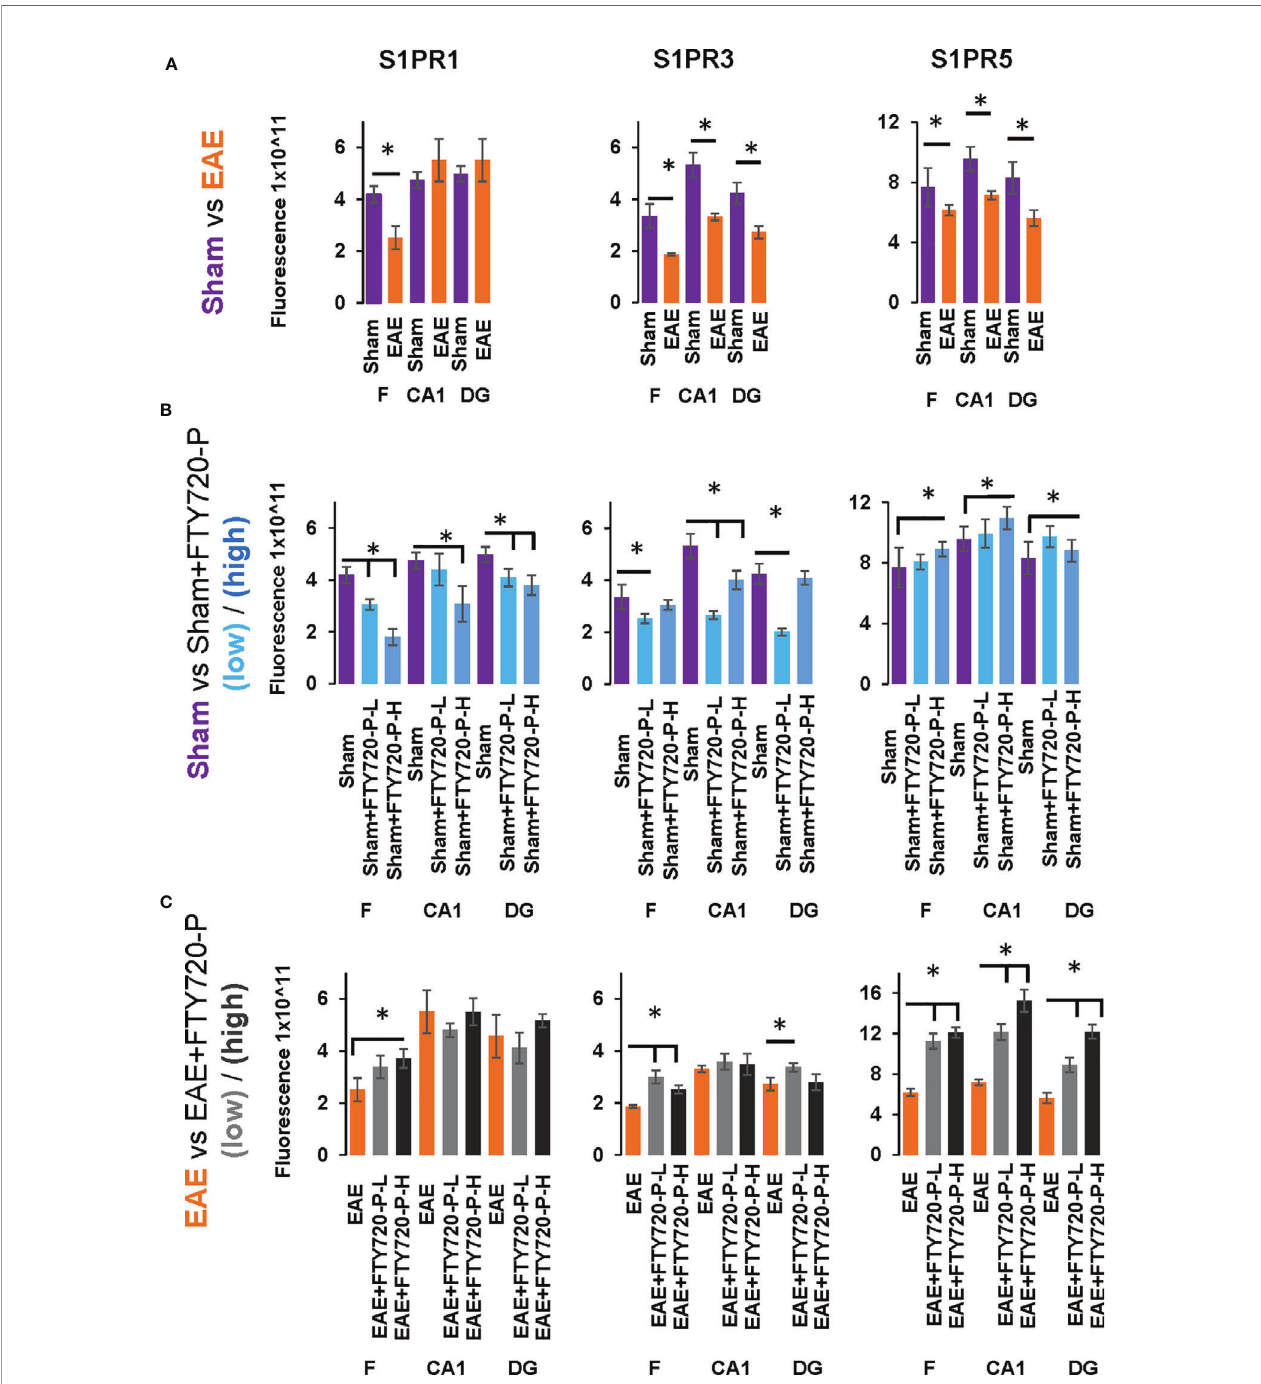
FIGURE 7 | Quanti fi cation of S1PR1, S1PR3 and S1PR5 expression in the hippocampus in EAE and following FTY720 treatment. (A) shows the EAE effect (EAE vs sham, images from Figure 4 ) from each hippocampal sub-region, with sham (purple) and EAE (orange), with signals captured using an arbitrary scale and estimated by ImageJ. (B) shows the direct FTY720 effect on sham mice (sham vs sham+FTY720, images from Figure 5 ) on S1PR1, S1PR3 and S1PR5 expression in the hippocampus with sham (purple), sham+FTY720-L (light blue) and sham+FTY720-H (dark blue). (C) shows the combined EAE and FTY720 effects (EAE vs EAE +FTY720, images from Figure 6 ) on S1PR1, S1PR3 and S1PR5 expression in the hippocampus with EAE (orange), EAE+FTY720-L (light grey) and EAE+FTY720-H (dark grey). N = 4 mice/group × 6 sections/mouse (*p<0.05). Experiments were replicated 3 times. Data were analyzed using one-way ANOVA and shown as mean ± standard error of the mean